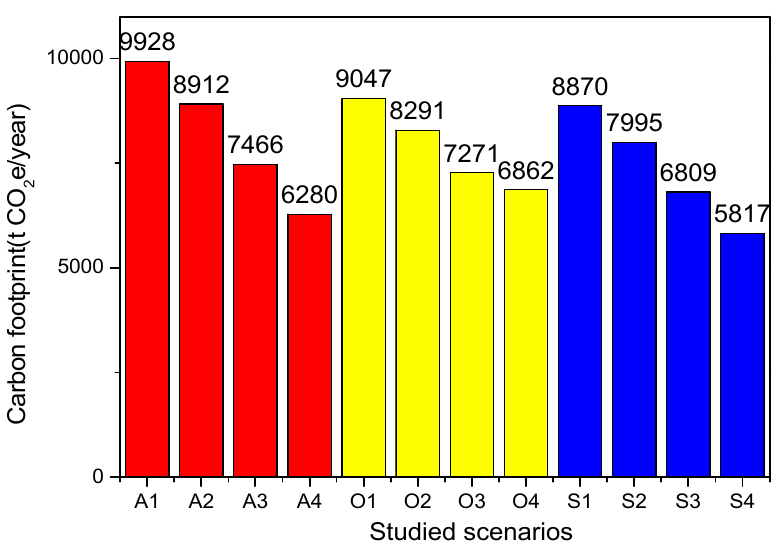
Figure 2. Carbon footprint of the twelve wastewater and sludge treatment scenarios.